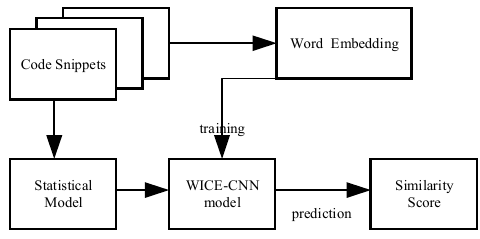
Figure 1. The flowchart of our work.